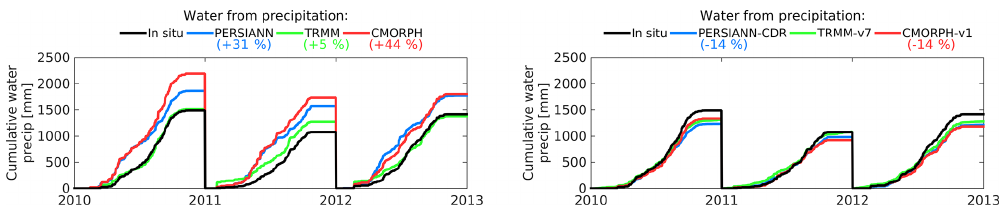
Figure 2. Cumulative average precipitation amount over the whole basin from the in situ network (black) and the three satellite product from quasi-real-time versions (left panel) and their reanalyzed versions (right panel): PERSIANN (blue), TRMM (green) and CMORPH